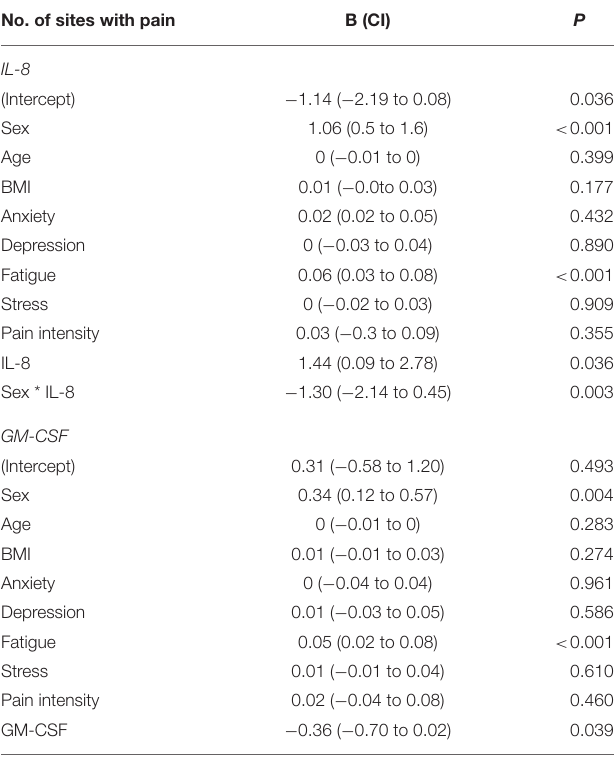
TABLE 4 | Relationship between IL-8 and GM-CSF and the widespreadedness of pain in the patient group. No. of sites with